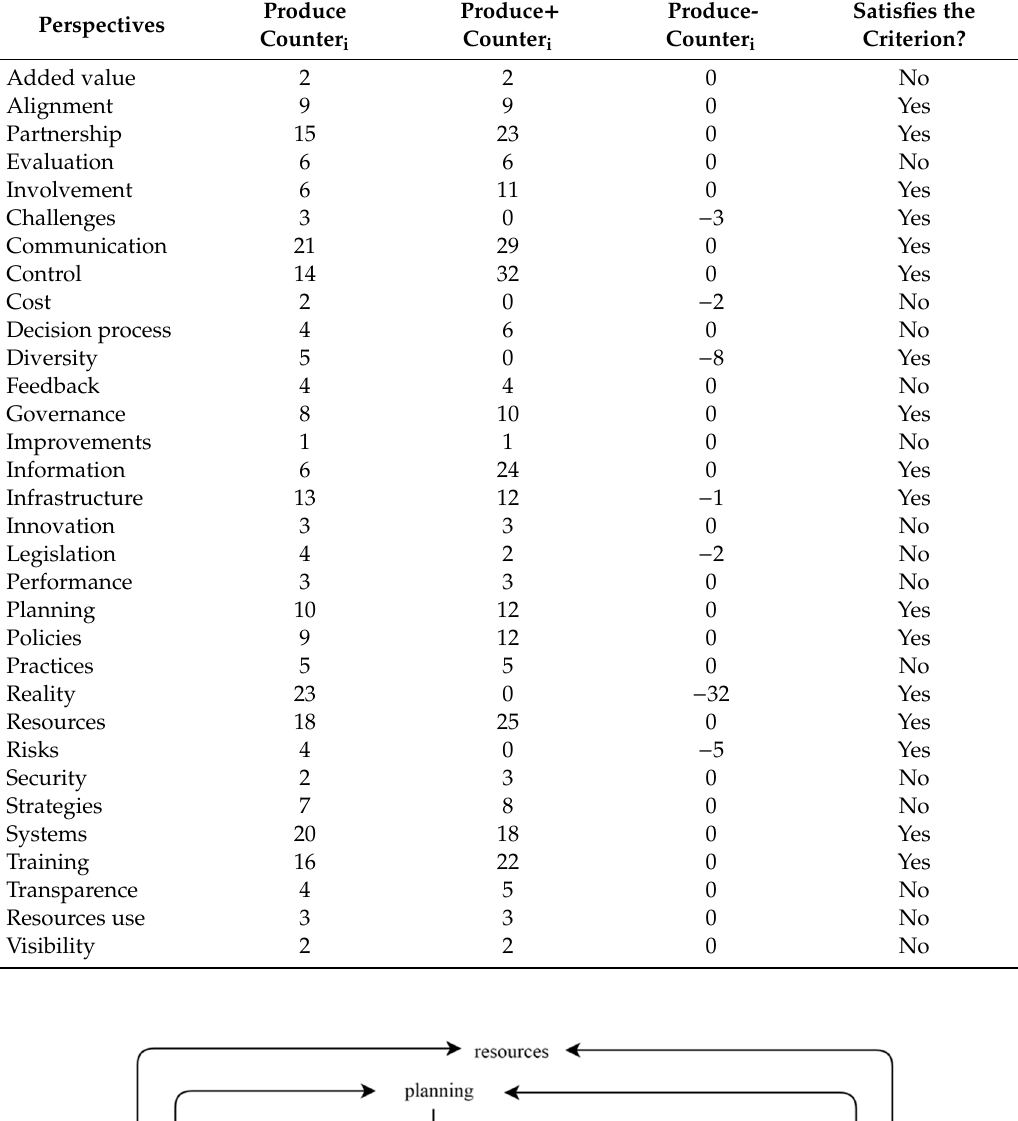
Table 5. Application of the criterion to select perspectives for the macro action plan using data from matrix.